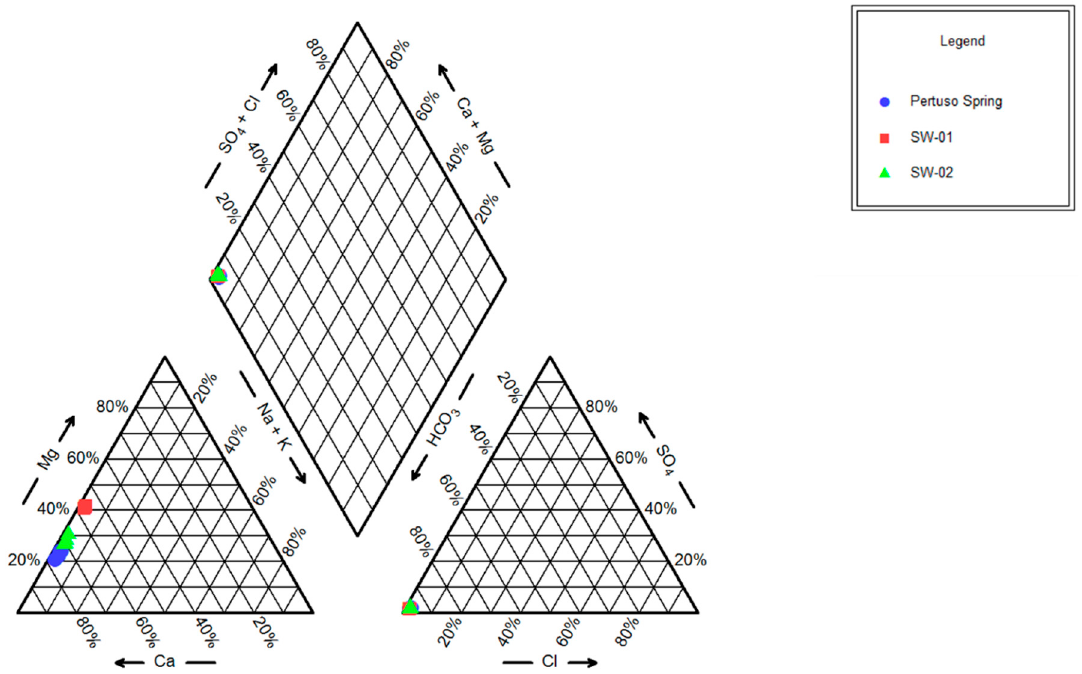
Figure 4. Piper plot for hydrochemical facies classification of groundwater and surface water.